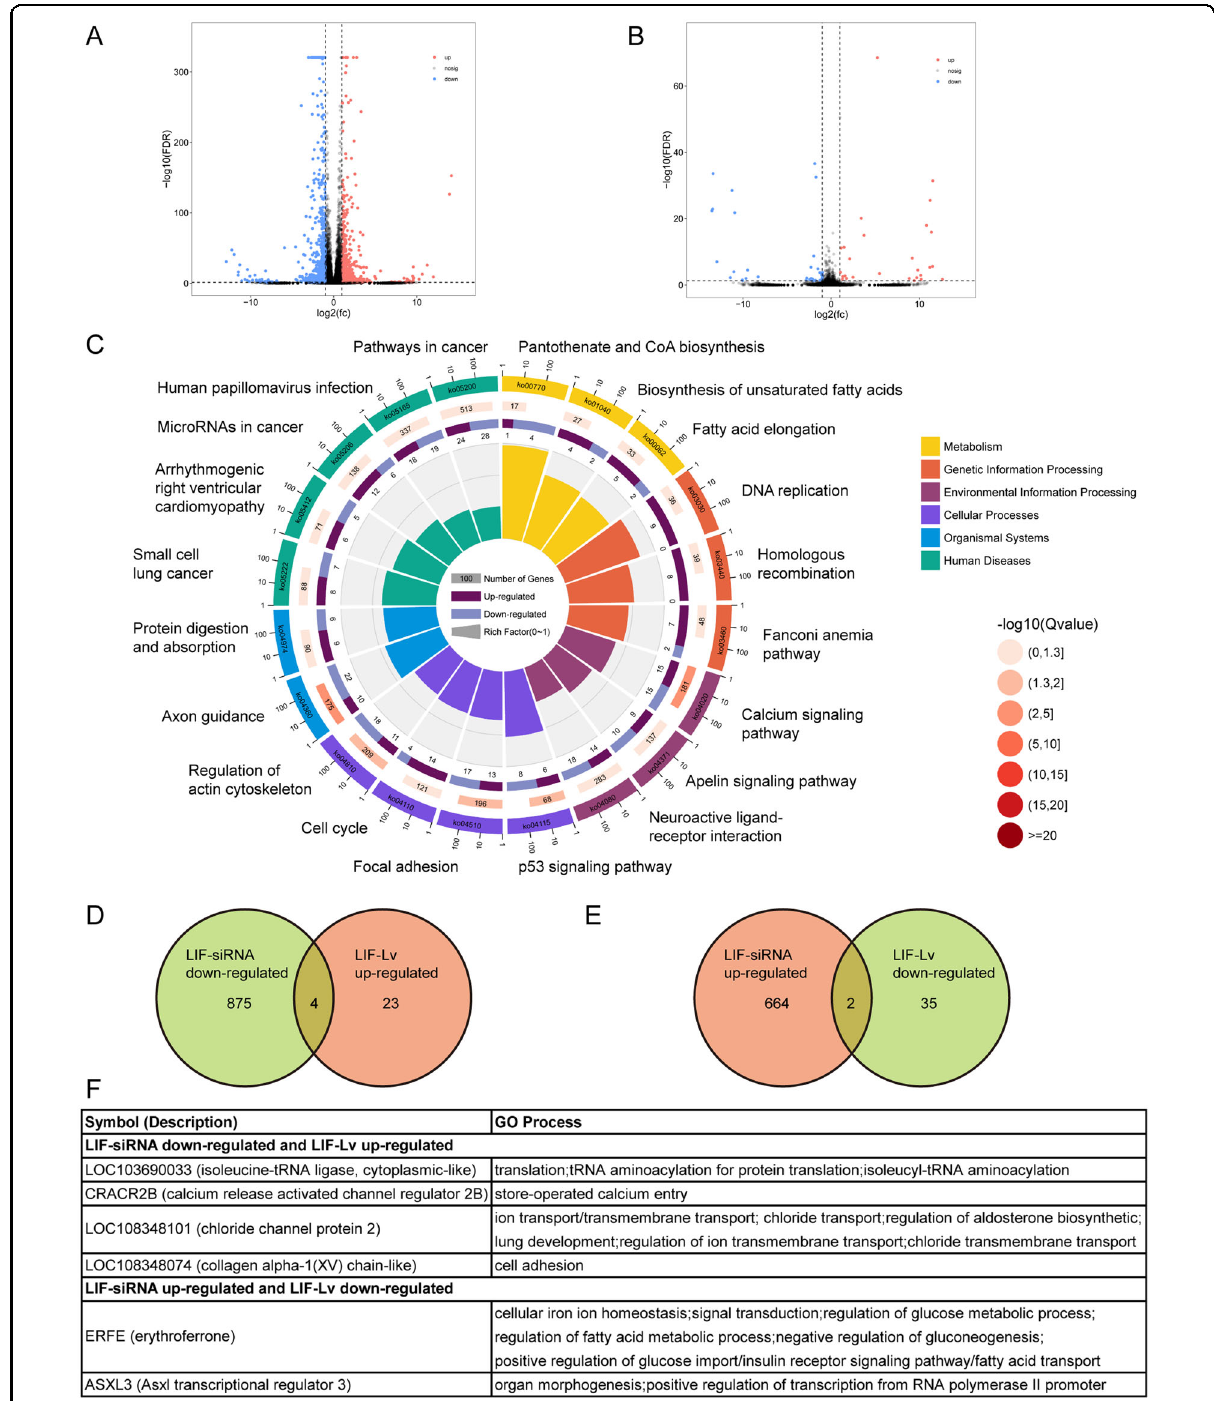
Fig. 7 LIF mediates gene expression changes in Schwann cells. A , B Scatter plots of differentially expressed genes in Schwann cells transfected with ( A ) LIF-siRNA or ( B ) LIF-overexpressing lentivirus (LIF-Lv). Red color indicates signi fi cantly upregulated genes and blue color indicates signi fi cantly downregulated genes. C Top 20 Enriched KEGG pathways of differentially expressed genes in LIF-siRNA-transfected Schwann cells. The length of bar graph in the innermost circle is correlated with the Rich factor of KEGG pathway. D Venn diagram of downregulated genes in LIF-siRNA- transfected Schwann cells and upregulated genes in LIF-overexpressing lentivirus-transfected Schwann cells. E Venn diagram of upregulated genes in LIF-siRNA-transfected Schwann cells and downregulated genes in LIF-overexpressing lentivirus-transfected Schwann cells. F The symbol, description, and GO process of overlaid differentially expressed genes.